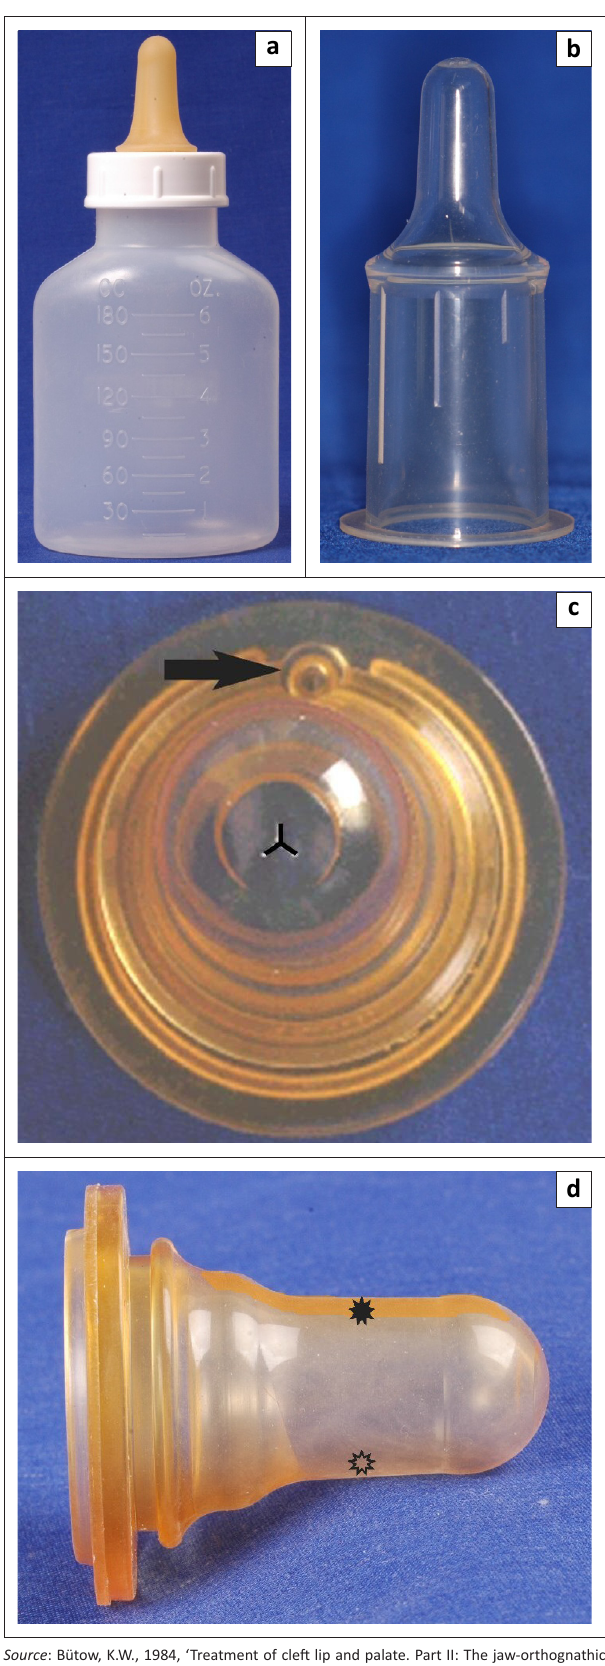
FIGURE 3: Feeding aids: (a) soft squeezable bottle, (b) teat: length and width flow indication, (c) Y-crosscut opening, (d) teat with hard top and soft